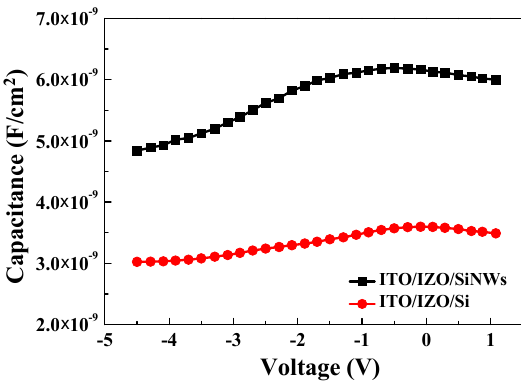
Figure 9. ( a ) I − V characterization curve of ITO/IZO/SiNWs; ( b ) log(|I|) − V curve of ITO/IZO/SiNWs.